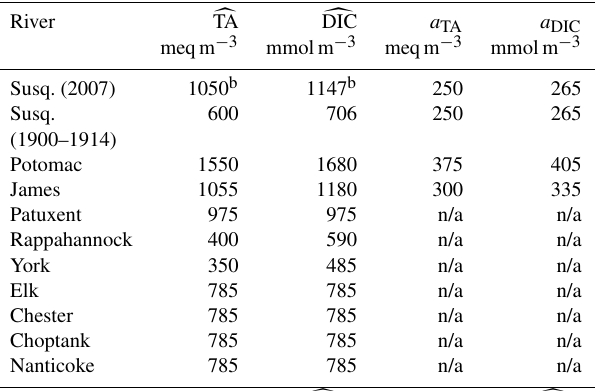
Table 2. River concentrations of total alkalinity a (TA) and dissolved inorganic carbon a (DIC) for the 10 rivers of the model (see Methods